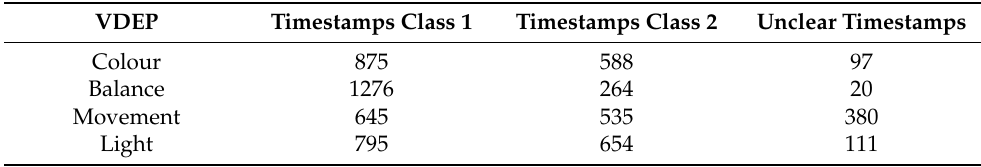
Table 1. The number of video seconds for each VDEP